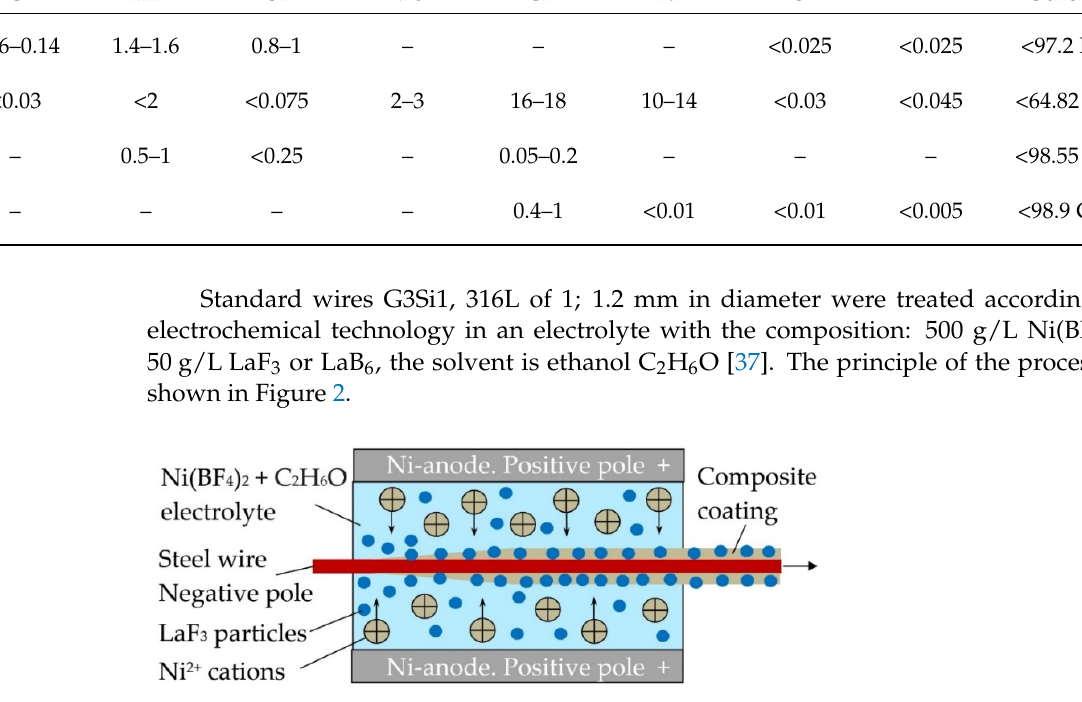
Table 1. Chemical composition of filler wires, wt.%.